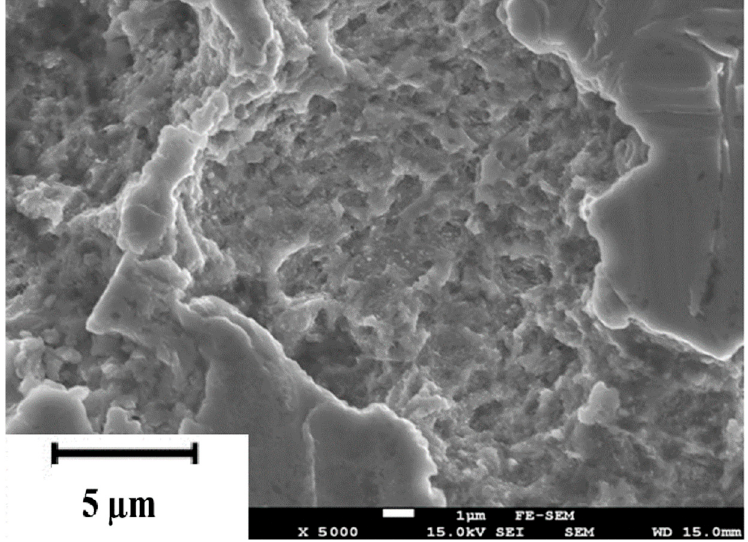
Figure 2. Microstructure of a laser-hardened specimen.